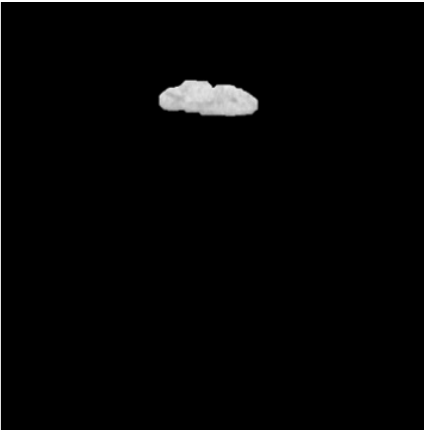
Figure 5. The result after applying erosion operation.